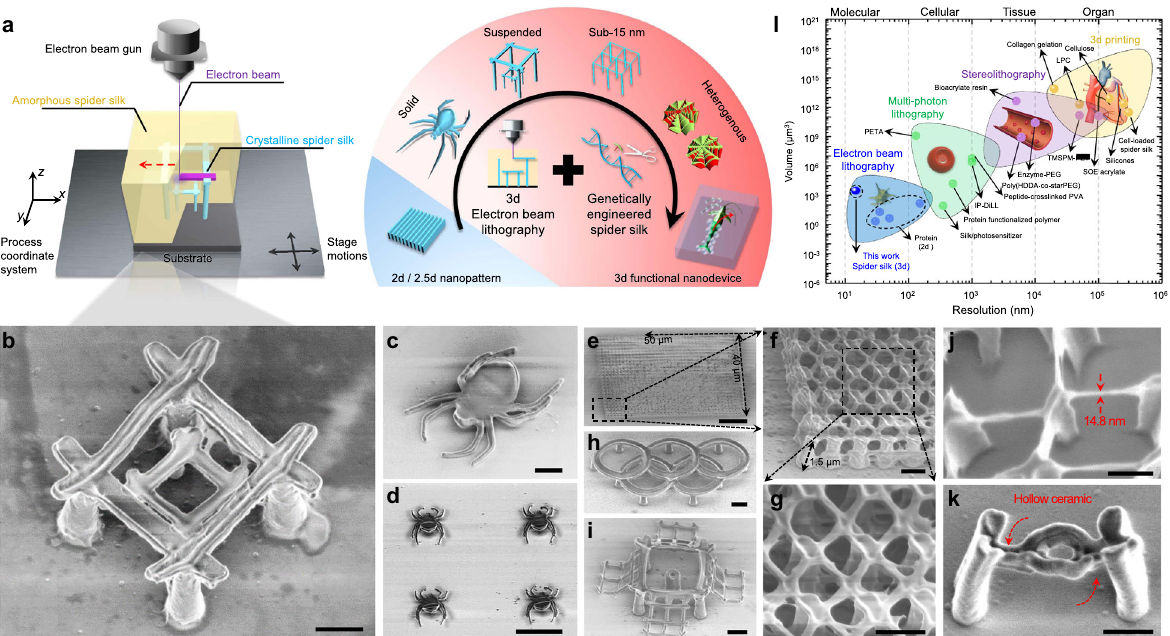
Fig. 1 Three-dimensional electron beam lithography (3d EBL) using recombinant spider silk proteins as the resist. a Manufacturing strategy and capabilities of 3d EBL. b Nanomatryoshka. c , d Nanospiders. e – g Large-scale nanowebs. h Nano-Olympic rings. i Nanocage. j Nanobridge. k Single-end anchored/supported hollow ceramic (Al 2 O 3 ) nanobeam. Scale bars in the SEM (scanning electron microscope) images: b , c 1 μ m; d 5 μ m; e 10 μ m; f – i 1 μ m; j 200 nm; k 500 nm. l The comparison between this work and the existing 3d micro-/nanofabrication methods in terms of resolution and scale. PETA pentaerythritol triacrylate, PVA polyvinyl alcohol, GelMA gelatin methacroyl, SOE-acrylate soybean oil epoxidized acrylate, Enzyme-PEG enzyme- embedded polyethylene glycol, HDDA hexamethylene diacrylate, TMSPM 3-(trimethoxysilyl)propyl methacrylate, PZT lead zirconate titanate, LPC liquid-